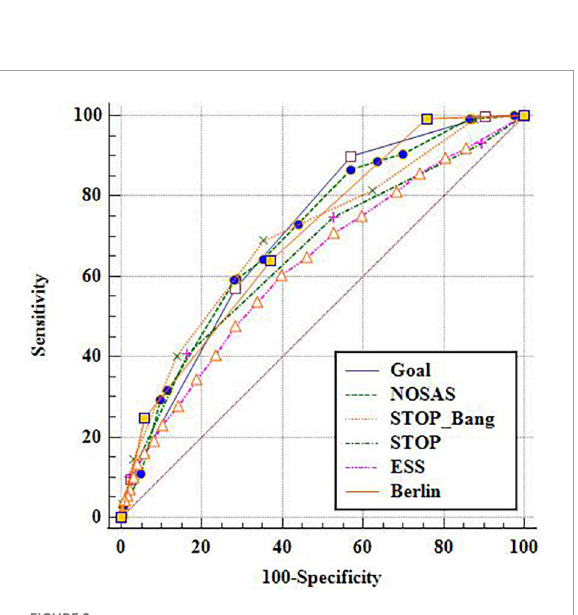
FIGURE2 ROC curve with apnea hypopnea index (AHI) 15 as cut-off point.